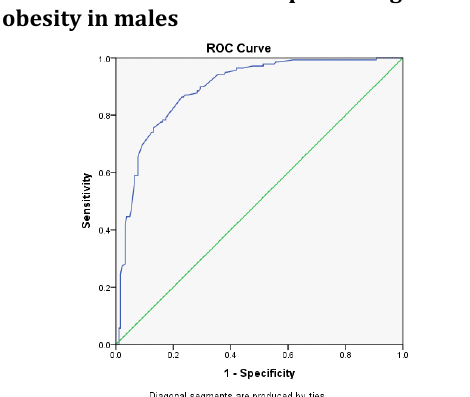
2b - ROC curve of MUAC in predicting central obesity in females